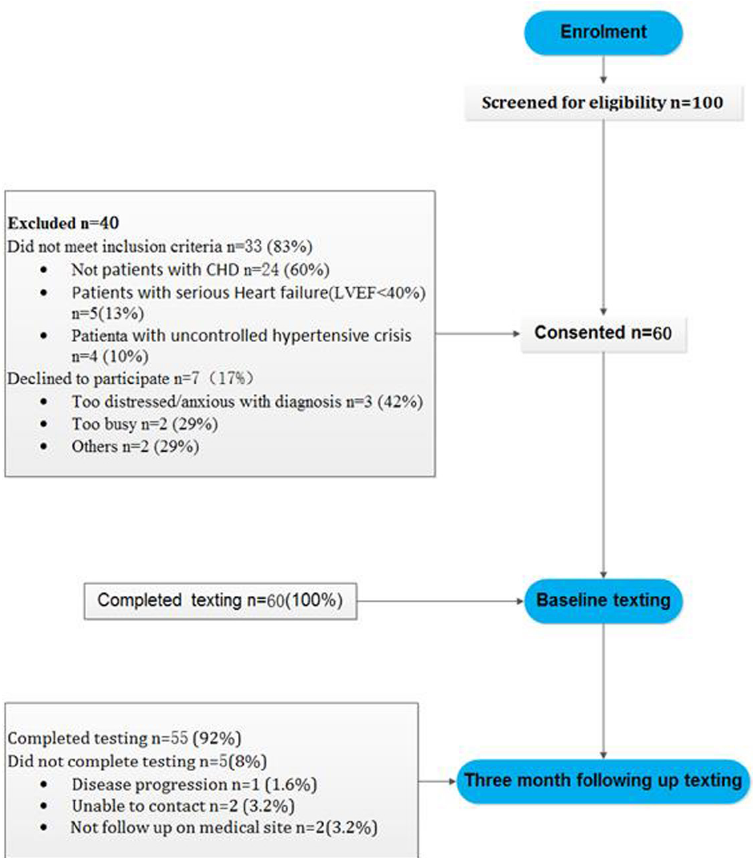
Figure 1: Experimental